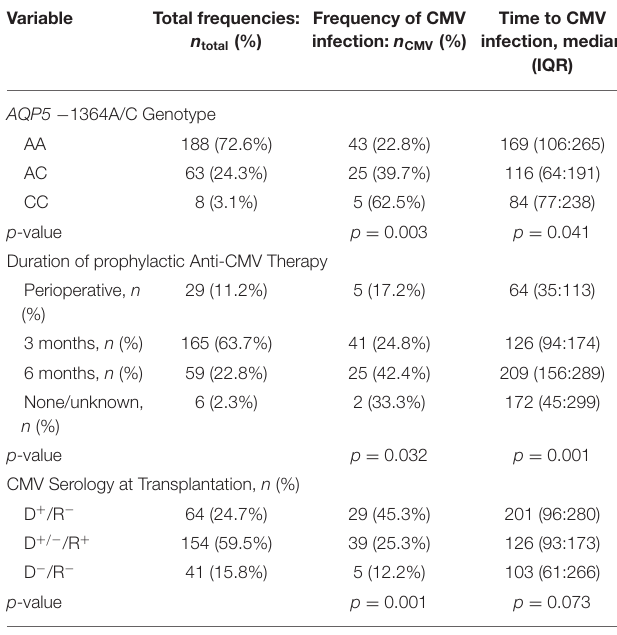
TABLE 2 | Characteristics of kidney transplantation recipients ( n = 259) stratified by frequencies and time of CMV infection onset.